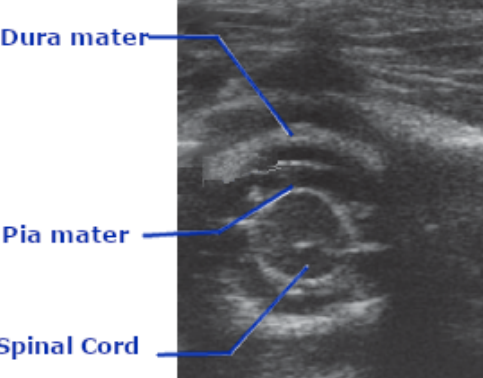
Figure 4. Ultrasound image of the spinal